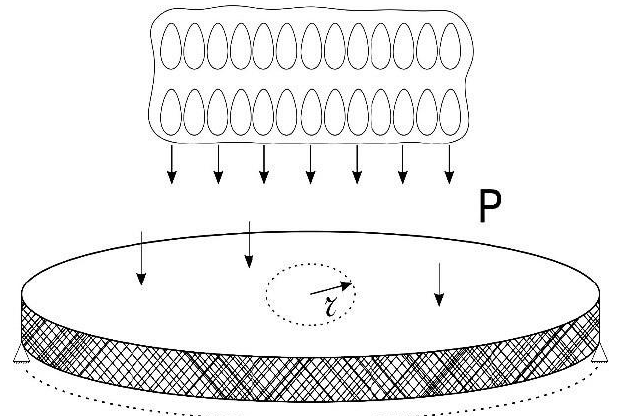
Figure 4. Drop-impact effect on the surface of the